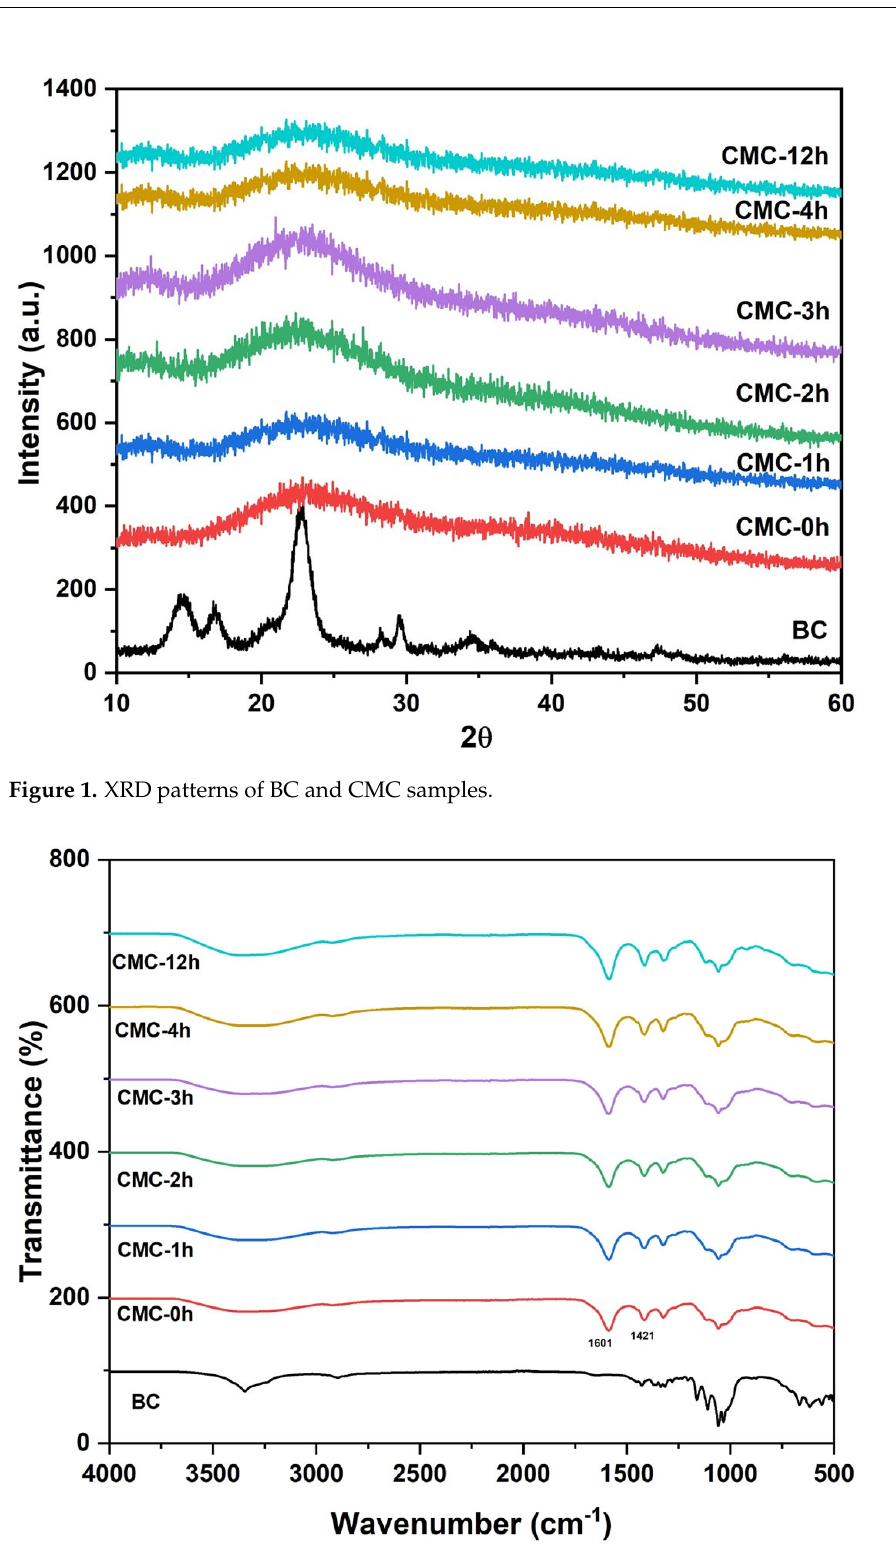
Table 1. Molecular weight and degree of substitution of CMC samples. Sample ID